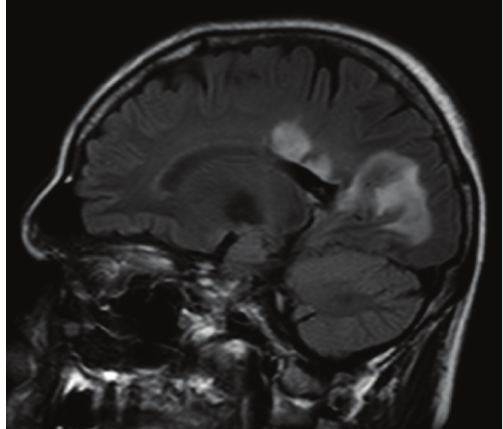
Figure 3: Sagittal FLAIR brain MRI shows a lesion cranial to the corpus callosum and the large occipital